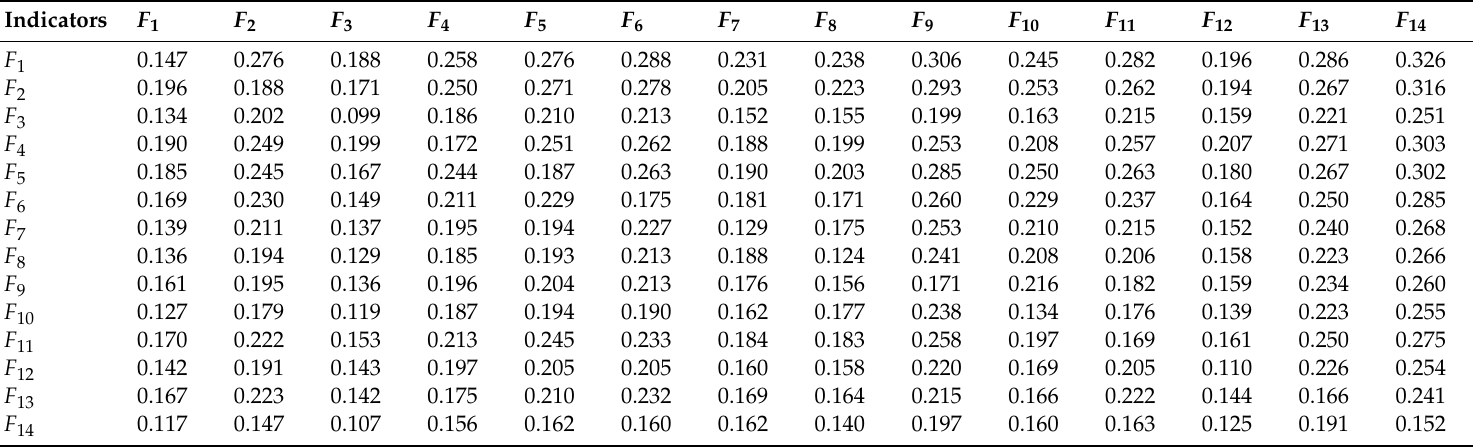
Table 7. The total relation matrix T